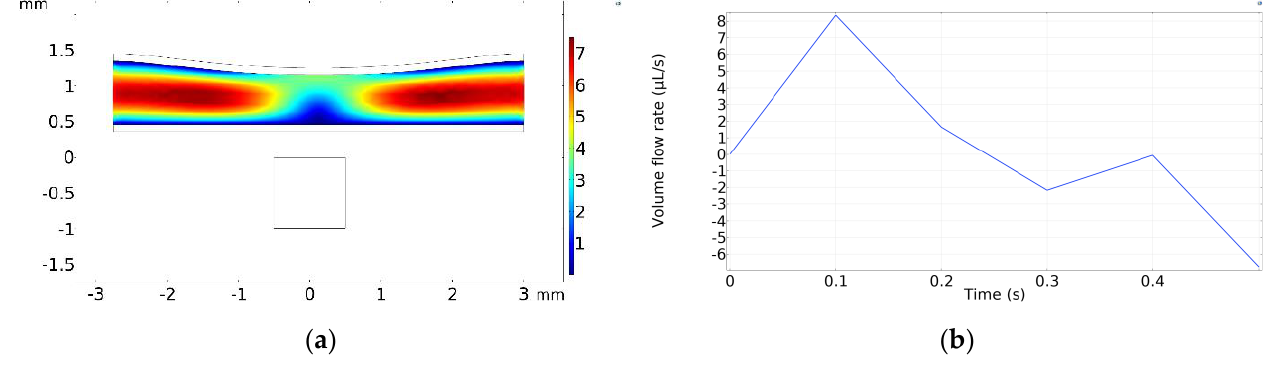
Figure 11. Simulation results for micropump without any valves. ( a ) Velocity field at t = 0.1 s. ( b ) Total volume flow rate vs. time.